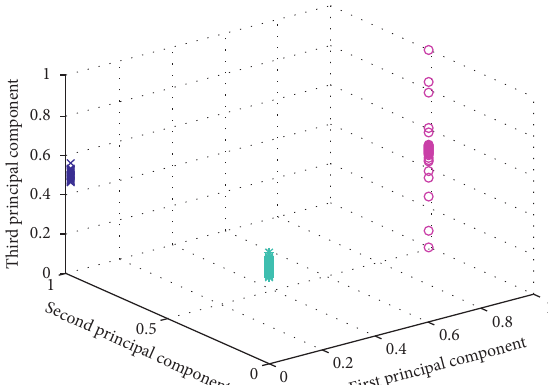
Figure 10: Recognition rate (98.33%) of test data.